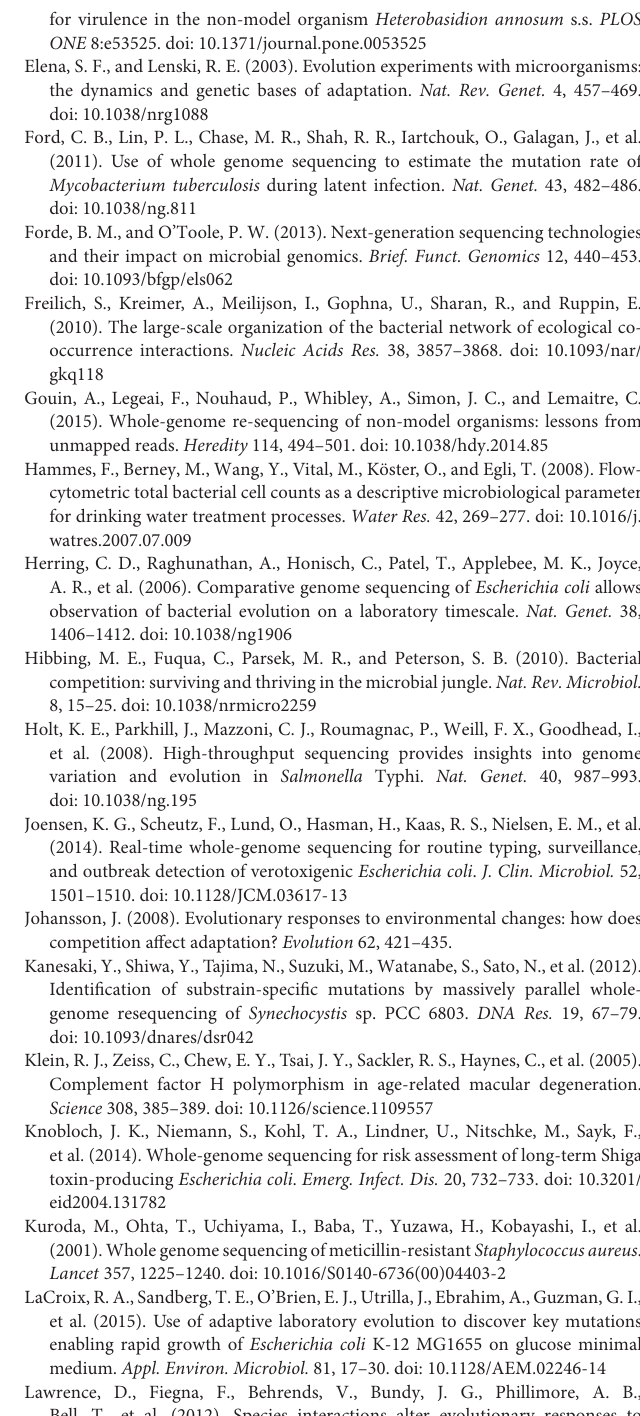
TABLE S2 | Resequencing statistics for E. coli . TABLE S3 | Resequencing statistics for S. aureus . TABLE S4 | Average sequencing depth and coverage for E. coli and S. aureus . TABLE S5 | Growth performance of each species in evolution experiments.